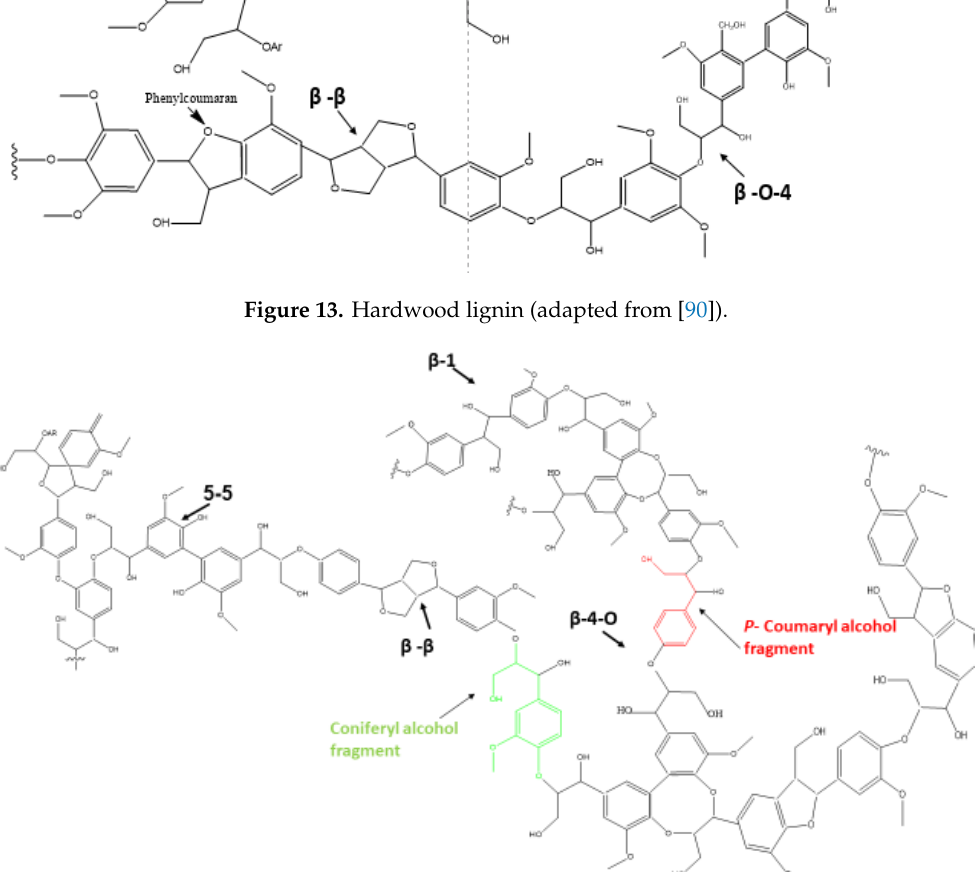
Figure 14 . Softwood lignin (adapted from [90]).